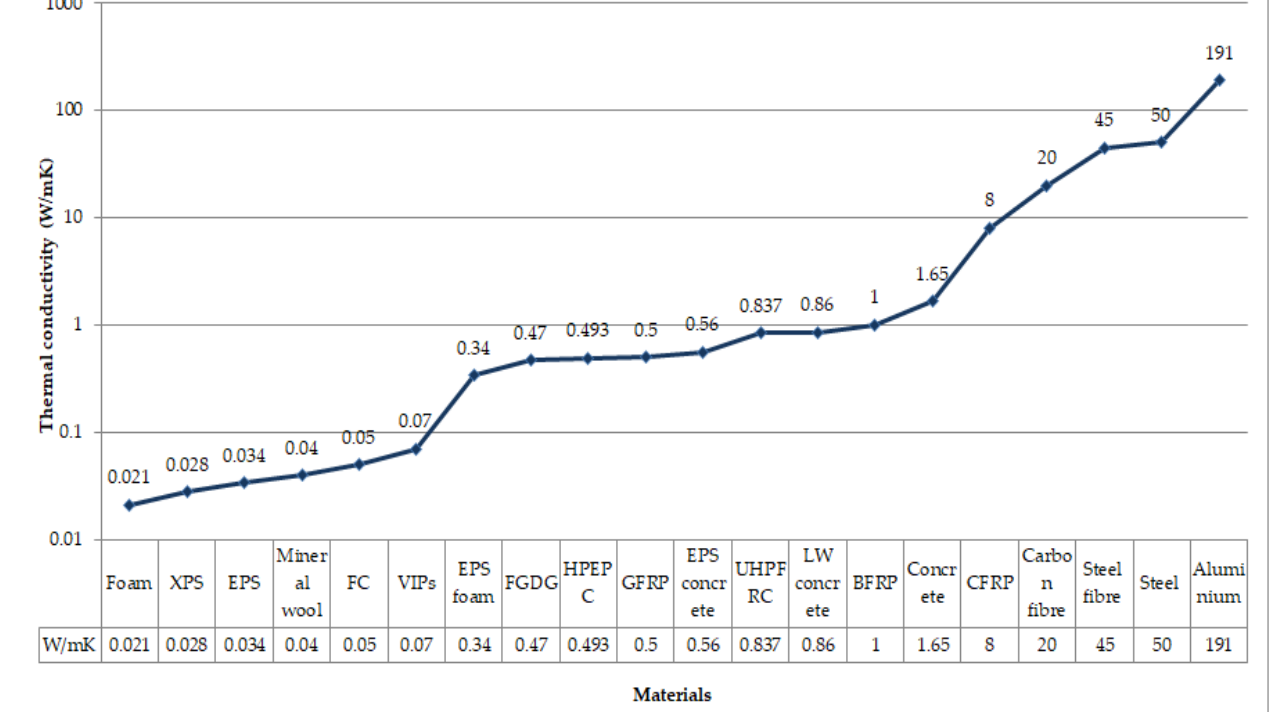
Figure 6. Thermal conductivities in the presented literature .